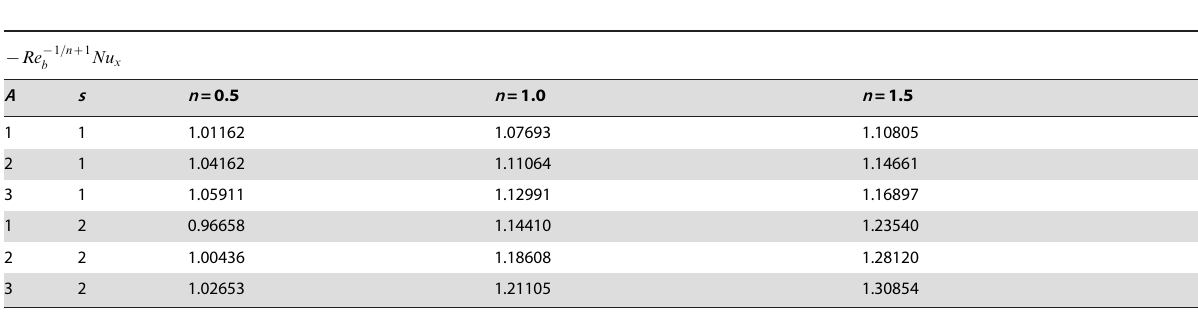
Table 1. The numerical values of the Local Nusselt number in the PST case when m ~ 1 and Pr ~ 1 are